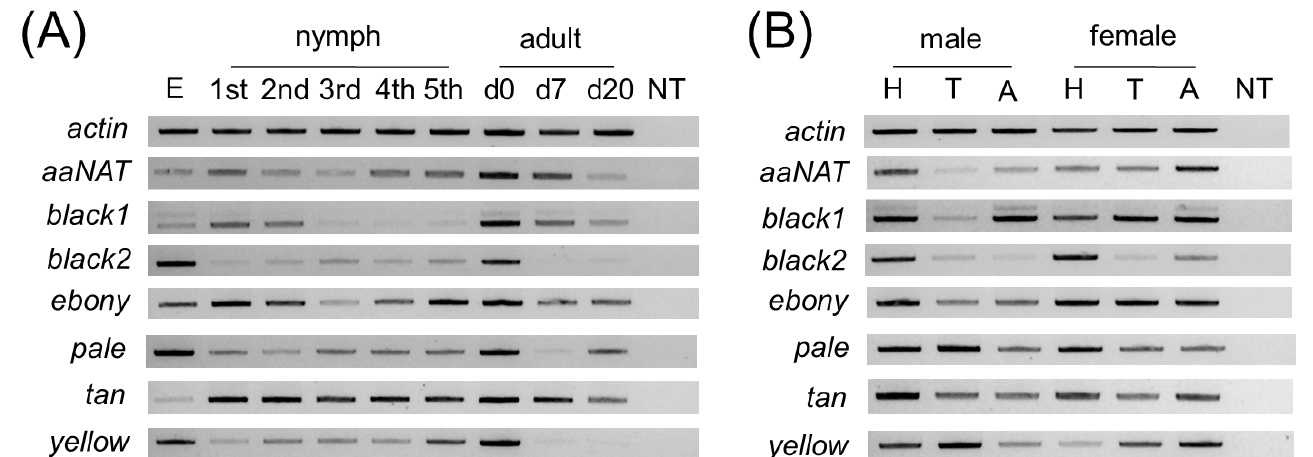
Figure 4. Expression profile of Lygus hesperus cuticular pigment-associated transcripts. ( A ) Devel- opmental expression of transcripts from egg (E) through nymphal development (1st–5th), and at varying points in adult maturation including adults at emergence (d0), and at 7 (d7), and 20 days (d20) post-eclosion. ( B ) Limited sex-specific tissue profile using head (H), thoracic (T), and abdominal ( A ) segments of reproductively mature adults (i.e., 7 day-old). Amplimers are ~500-bp fragments of the transcripts of interest. Gels shown are representative of results obtained across three replicates.